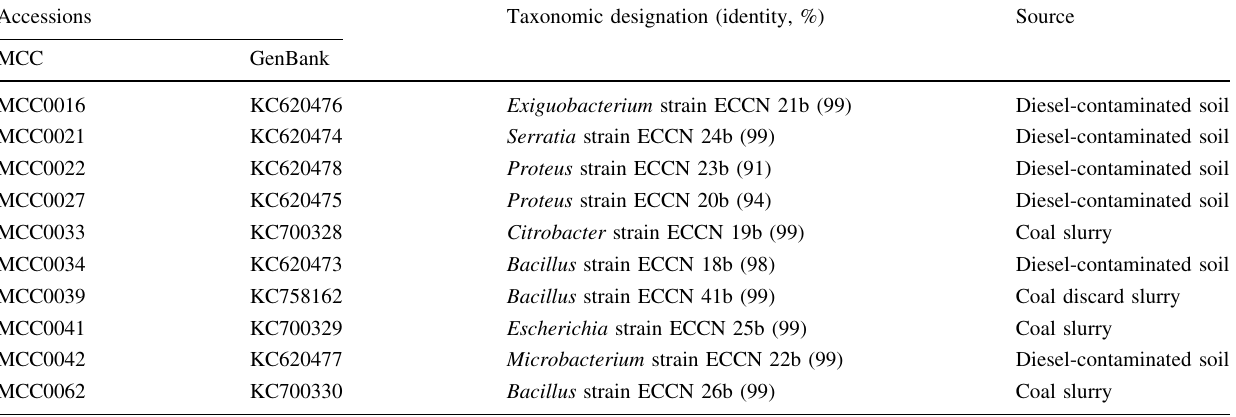
Table 2 Identification of bacteria with coal-degrading potential. Isolates were from slurries of coal tailings, from rhizosphere of grasses on coal discard dumps, and from diesel-contaminated soil Accessions Taxonomic designation (identity,